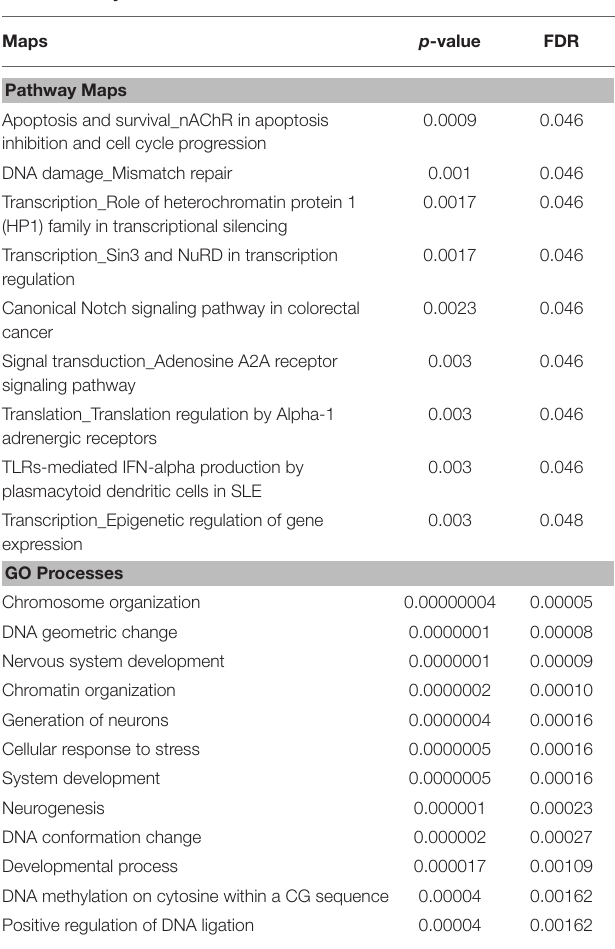
TABLE 4 | Pathway Maps and Gene Ontology Processes related to genes included in the expression-based polygenic risk score of the 5-HTT in the